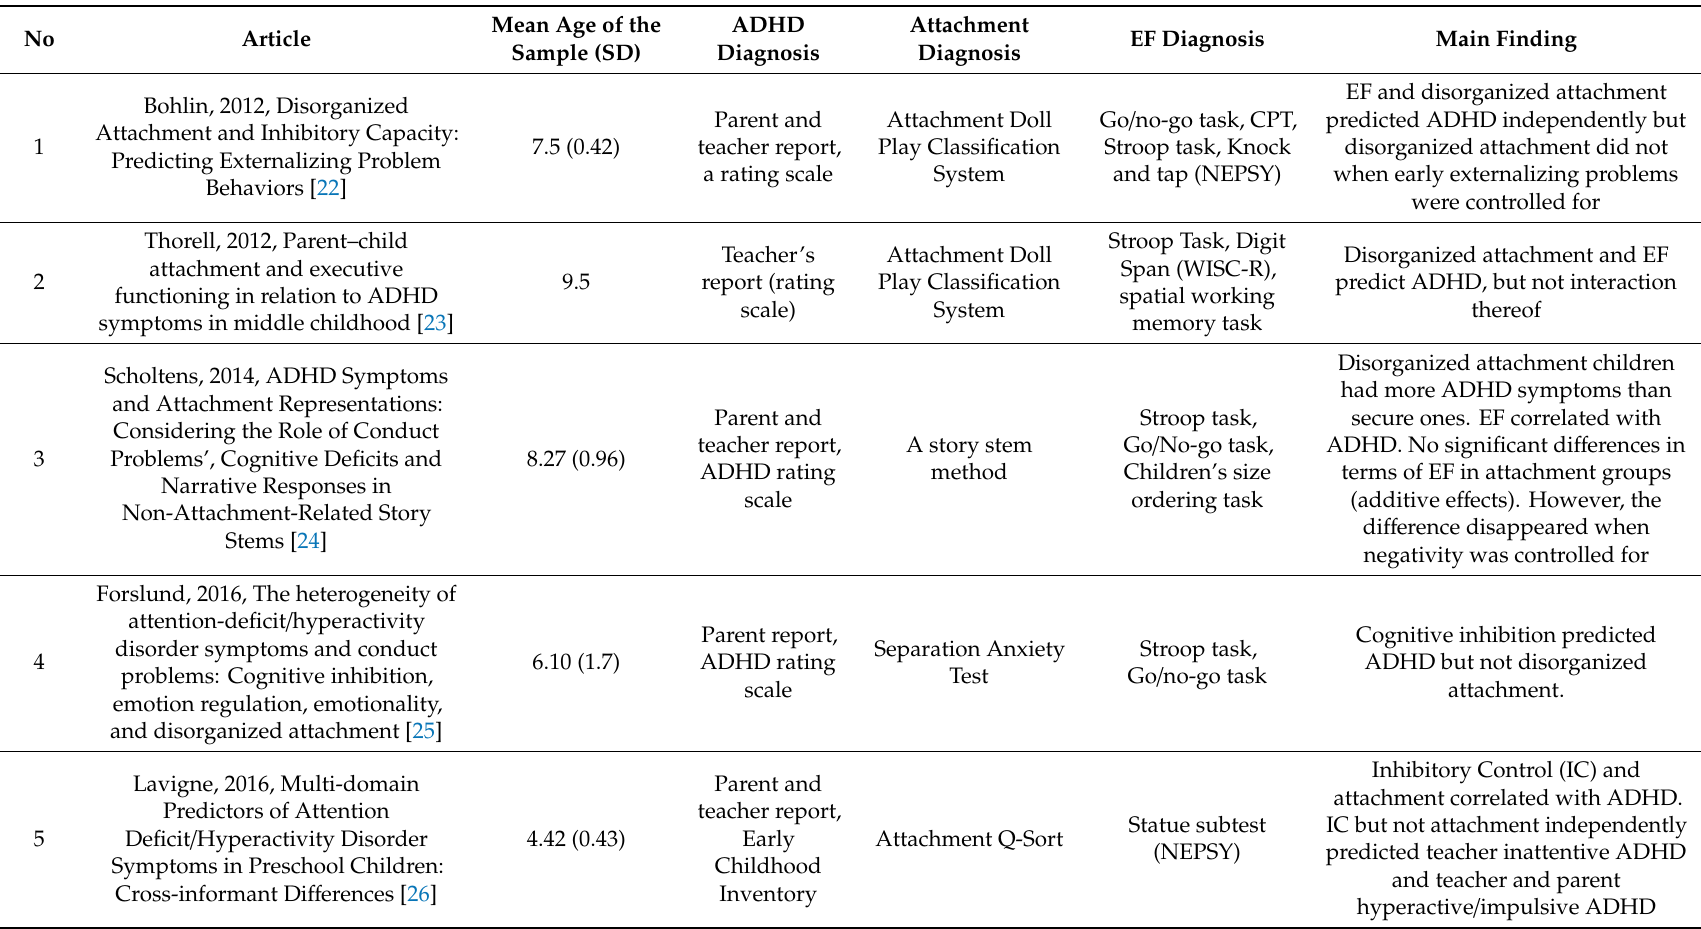
Table 2. Articles included in the